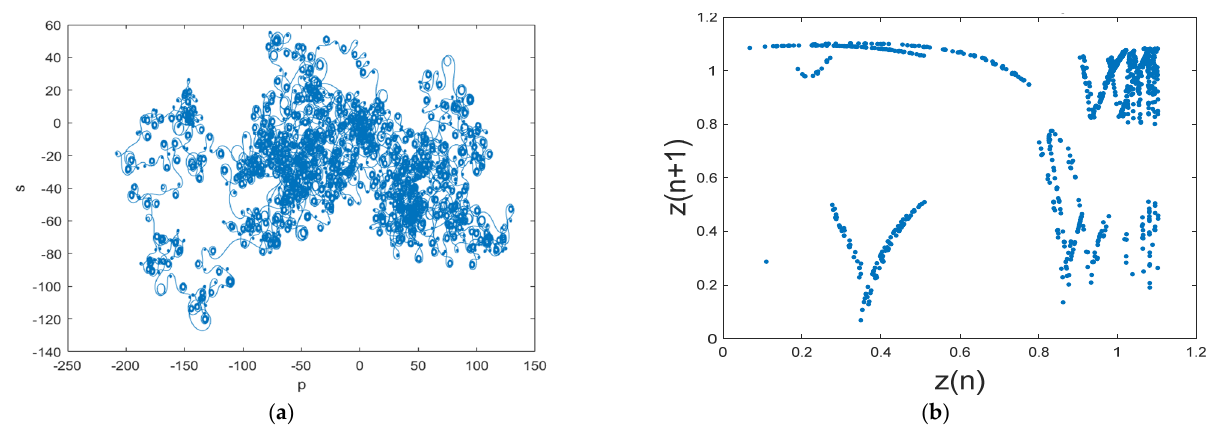
Figure 2. Output MATLAB simulation of the financial chaotic system (1) with Y (0) = (0.4, 0.2, 0.5) and ( a, b, c ) = (7.6, 0.1, 0.2): ( a ) x-y plane, and ( b ) Poincaré section of the financial chaotic system (1).